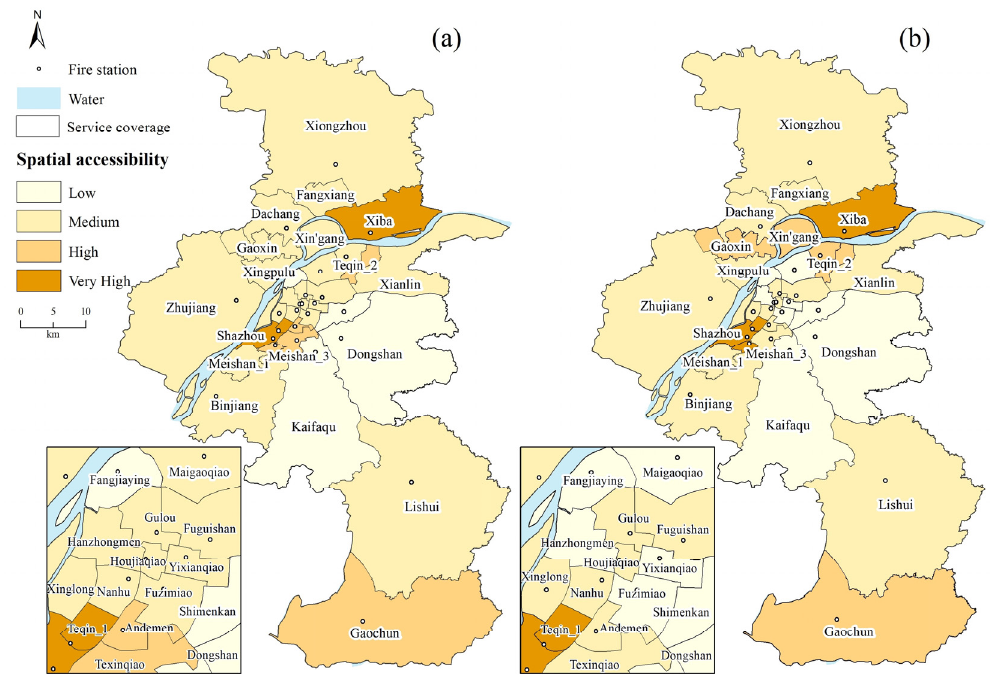
Figure 9. The spatial accessibility levels of fire stations using ( a ) E2SFCA, and ( b ) FC2SFCA.